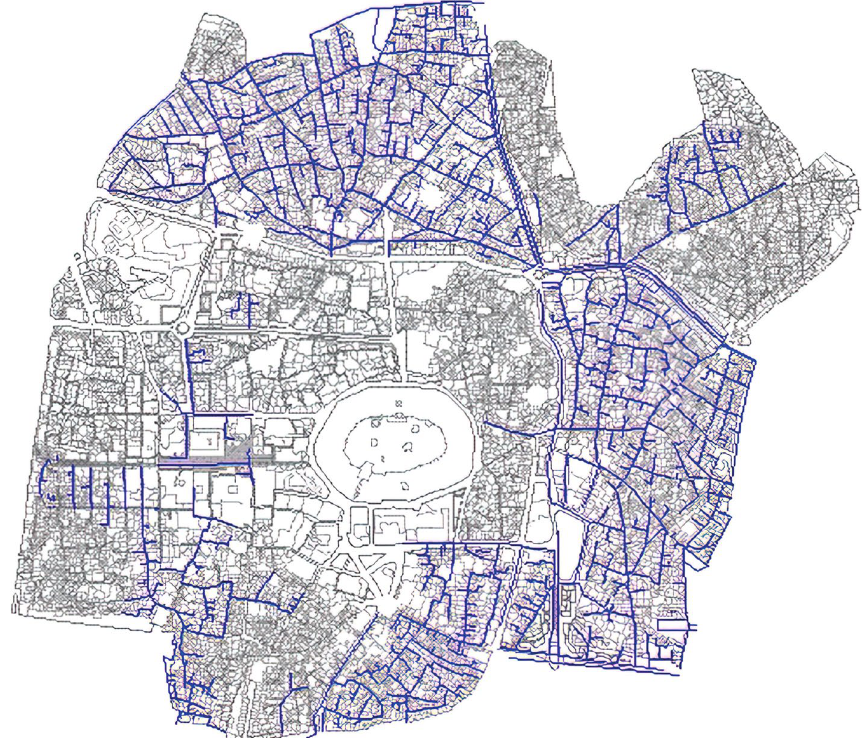
Fig. 10 Map Provided by the GTZ and DOCA entitled ‘Technical Infrastructure Planning and Execution / Rehabilitated Water Supply Network (2003)’ (Source: GTZ and DOCA